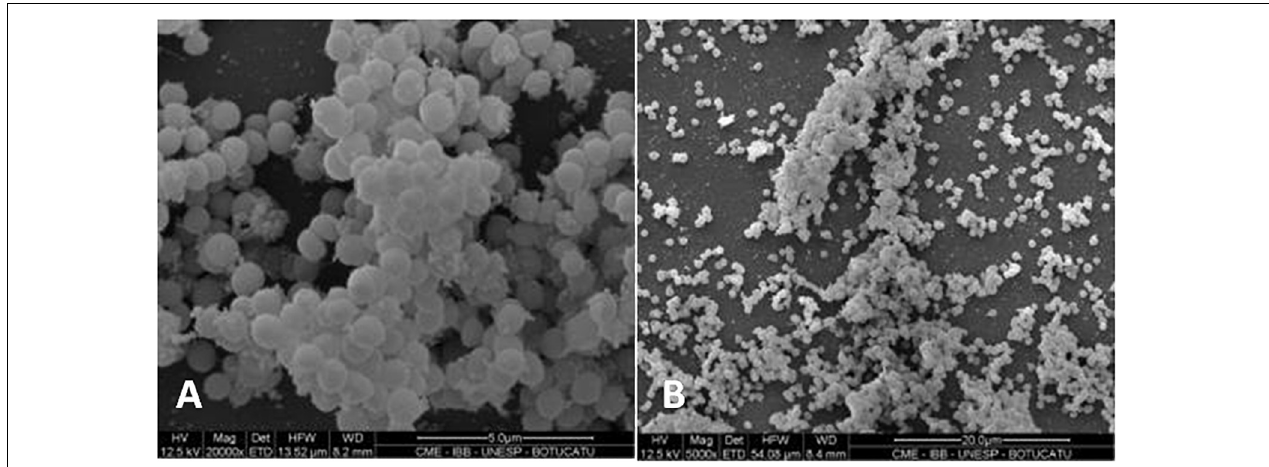
FIGURE 1 | Scanning electron micrograph showing the biofilm structure in Staphylococcus saprophyticus . Magnification: (A) 20,000 × ; (B) 5,000 × .